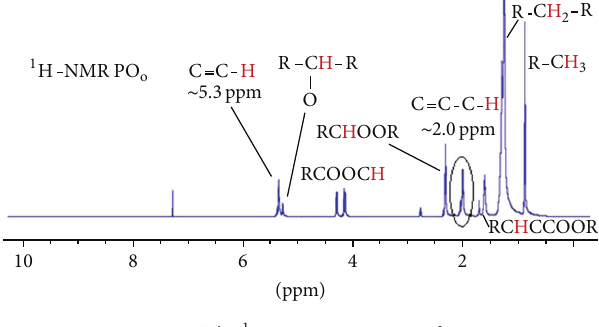
Figure 1: The 1 H-NMR spectrum of PO